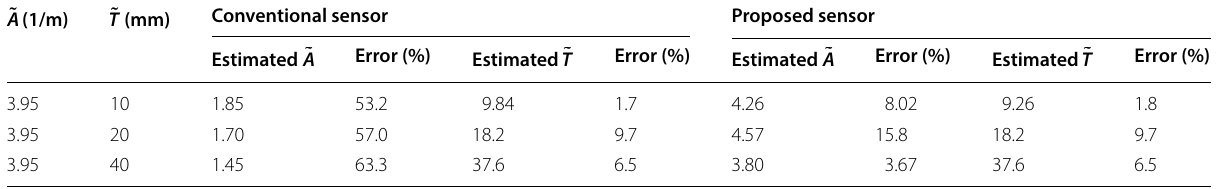
Table 2 Results of curvature amplitude period is changed, and the respective error rates ˜ A